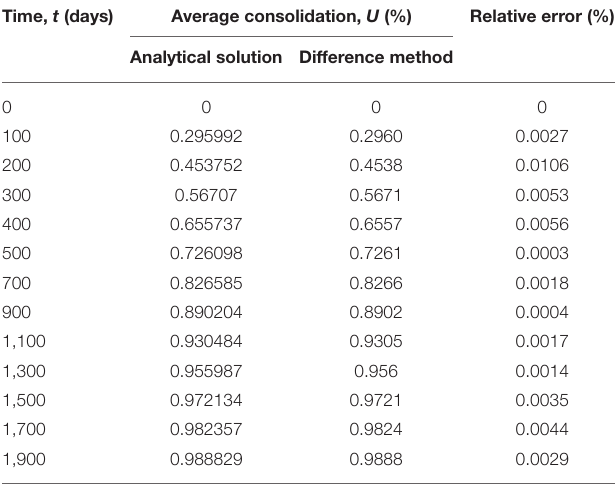
TABLE 1 | Average consolidation degree of the foundation.